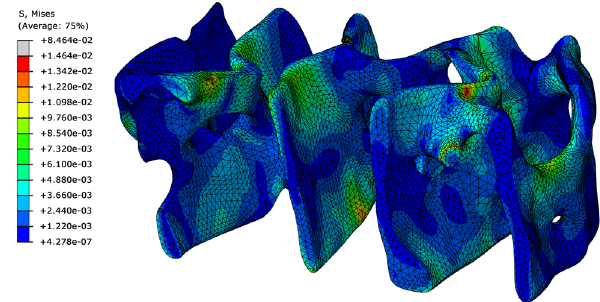
Figure 6: Mises stress distribution in the bone slice.